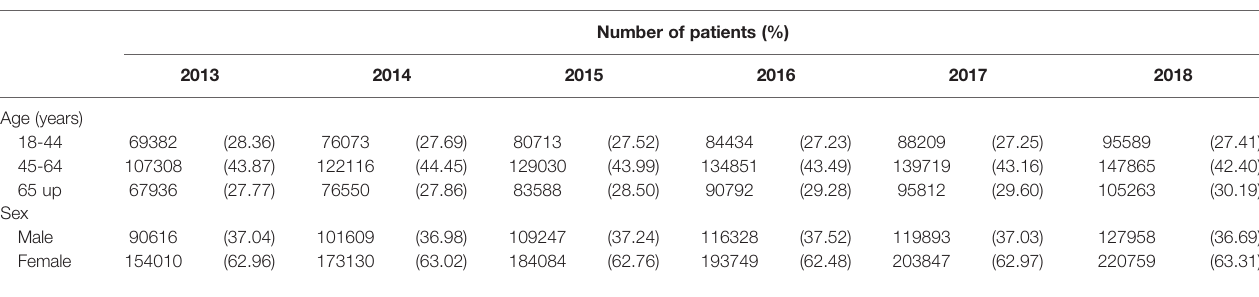
TABLE 1 | Demographic characteristics of included patients, 2013-2018.